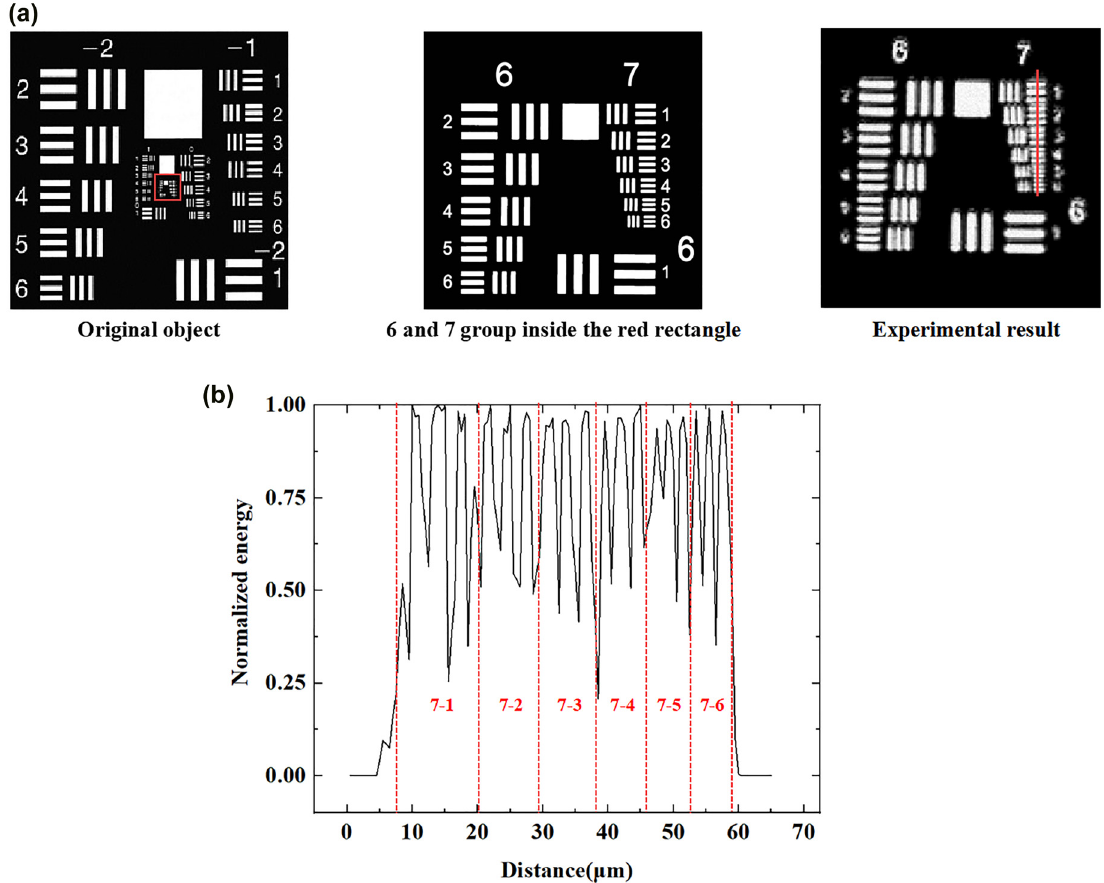
Figure 7: The experimental results of resolution chart by applying SPI technique using our metasurface. (a) The USAF1951 resolution test chart and the imaging results on the group 6 and 7 parts (inside the red rectangle). (b) The 1-D slice of the resolution targets group 7 (the red line on the experimental